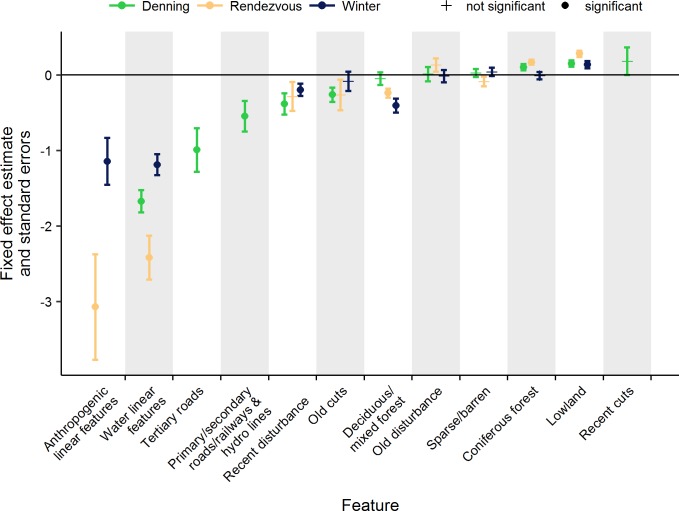
Parameter estimates and standard errors for fixed effects in the top selected models using the Functional Availability method, describing selection of landscape variables by wolves in northern Ontario, Canada, 2010–2014.Symbols indicate significance for α = 0.05. Negative values indicate selection.